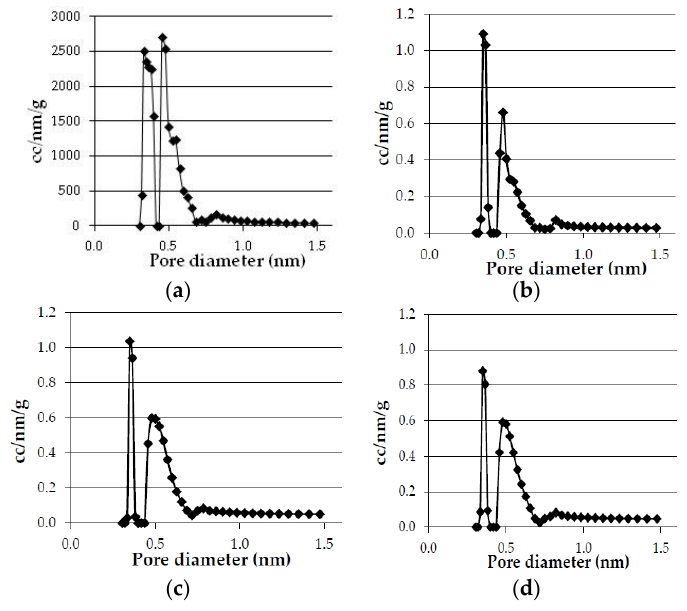
Figure 2. Effect of temperature in pore size distribution of the bioreducers obtained at 20 °C ∙ min − 1 from olives and eucalyptus samples. ( a ) Olives (750 °C); ( b ) Olives (600 °C); ( c ) Eucalyptus (750 °C); ( a ) Eucalyptus (600 °C).